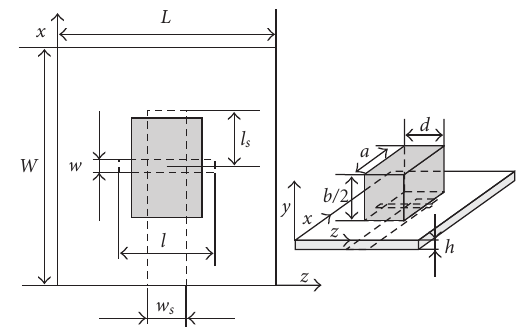
Figure 1: Geometry of the slot-coupled rectangular DRA, compre- hensive of finite ground plane and feeding